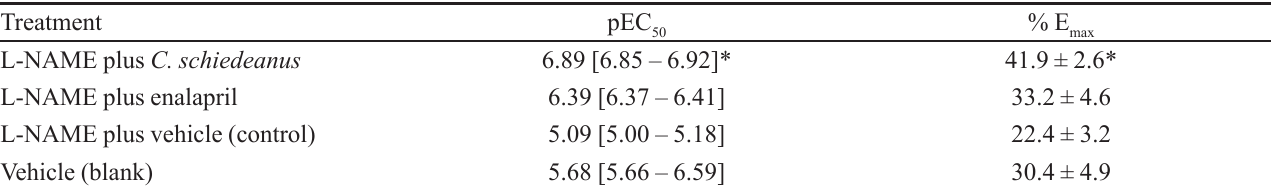
(-log[EC ]) and % E values (% of maximal effect) induced by Ach (10 -10 - 10 -4 M) in isolated aortic rings TABLE I - pEC 50 50 max contracted with FE (10 -6 M) from Wistar rats previously treated with: (1) ethanolic extract of C. schiedeanus Schltd (200 mg/kg/ day, p.o.) plus L-NAME (10 mg/kg, i.p.), (2) enalapril (reference drug, 10 mg/kg/day, p.o.) plus L-NAME (10 mg/kg, i.p.), (3) vehicle (control, olive oil 0.1 mL/100 g, p.o.) plus L-NAME (10 mg/kg, i.p) and (4) vehicle (blank, olive oil 0.1 mL/100 g, p.o.). Results are expressed as means, fiducial limits and S.E.M., respectively. *p<0.05 with respect to the control